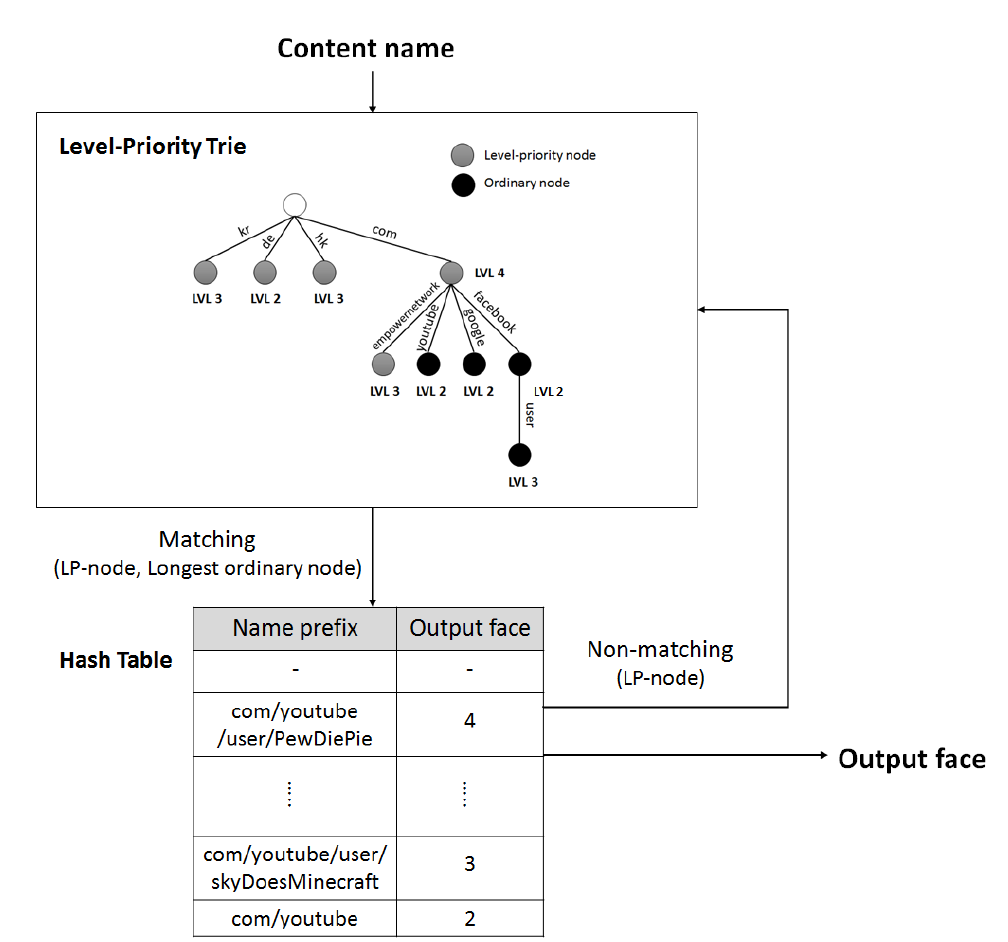
Figure 2. Level-priority trie and a hash